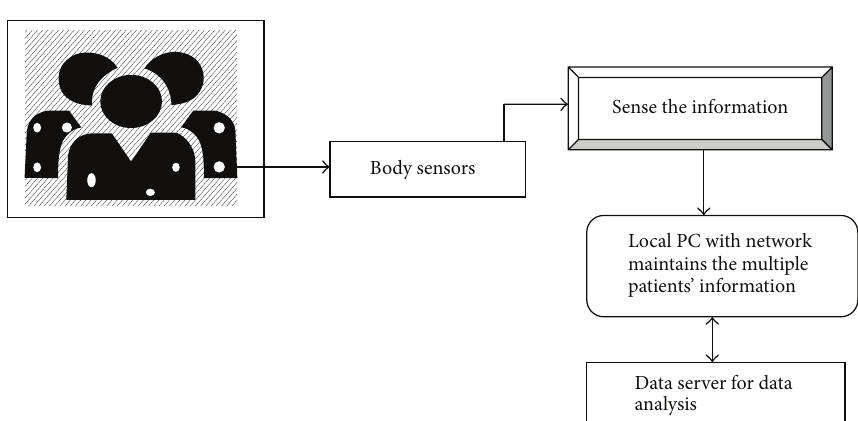
Figure 1: Architecture diagram of GTSSE